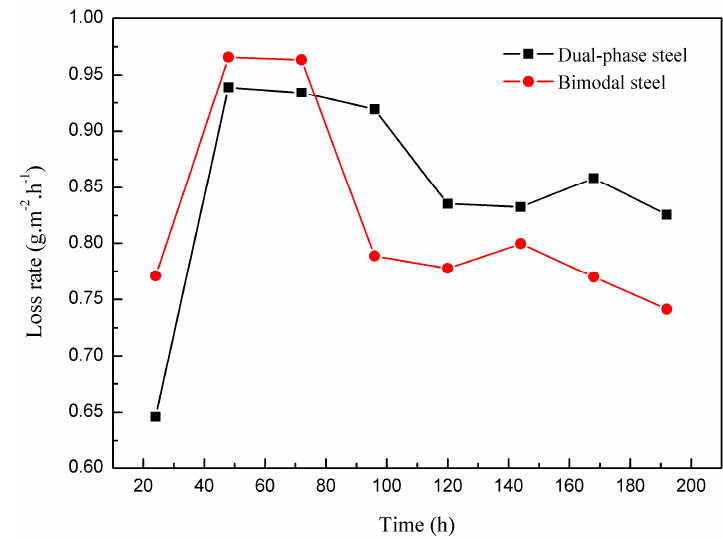
Metals 2017 , 7 , 316